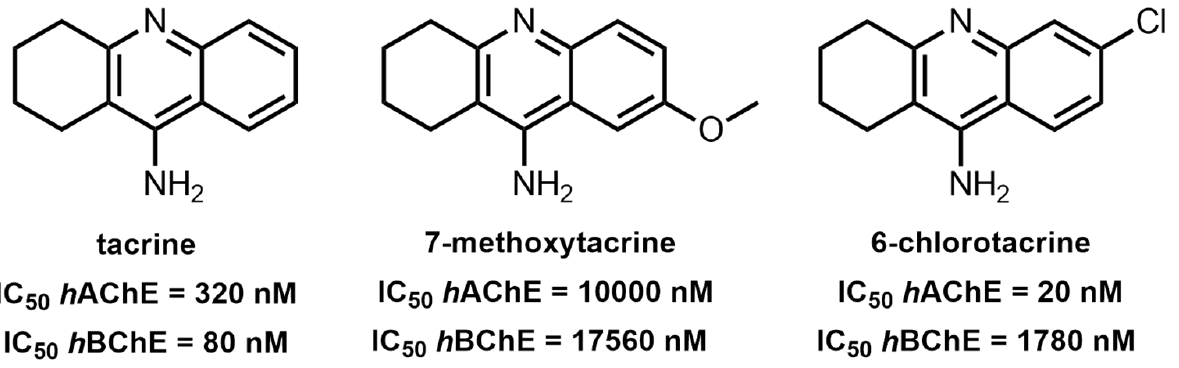
Figure 1. Tacrine (THA), 7-metoxytacrine (7-MEOTA), 6-chlorotacrine (6-Cl-THA), and their IC 50 values.